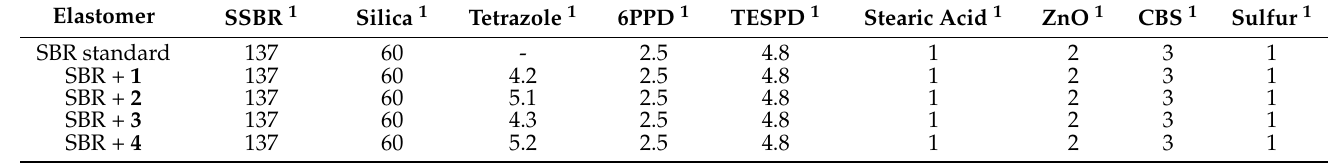
Table 3. Components of final elastomeric